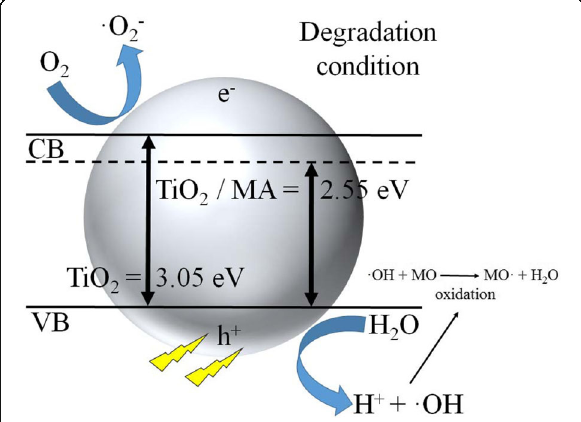
Fig. 11 Schematic diagram of the band levels of 2TiMA-ET and the possible reaction mechanism of the photocatalytic